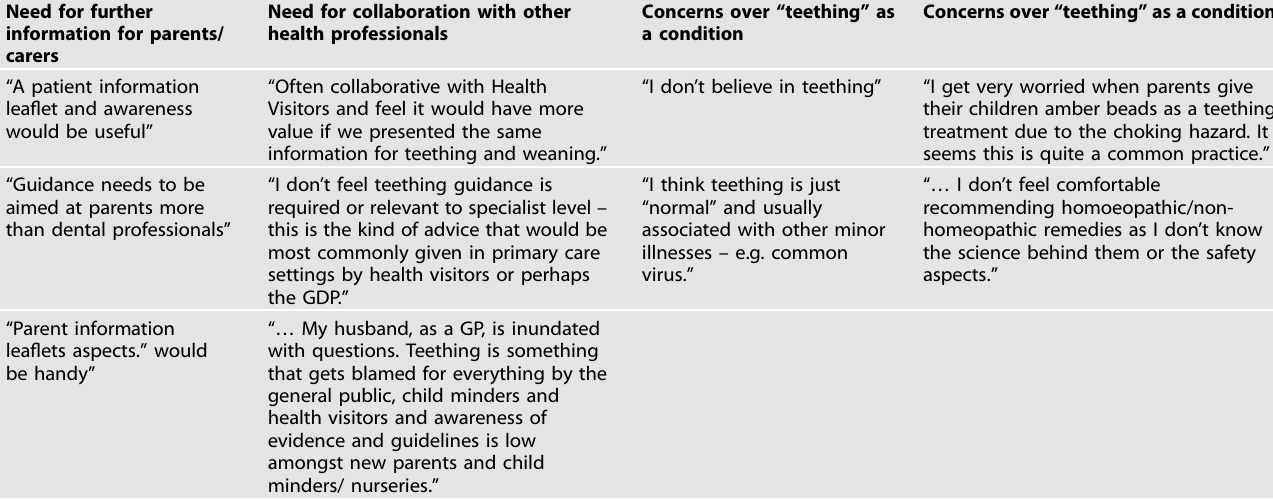
Table 3. Free-text comments grouped by